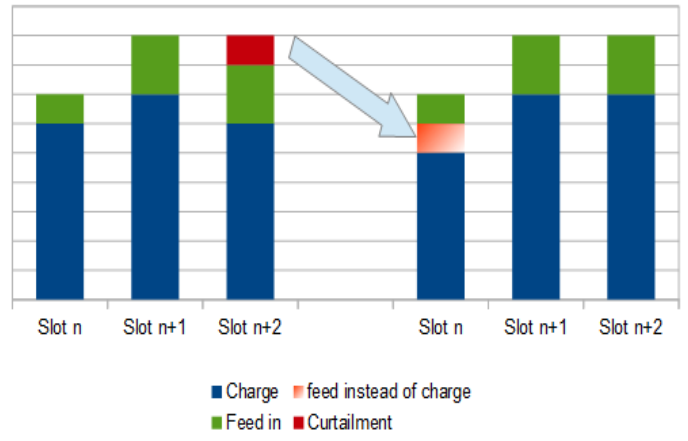
Figure 6. A graphical illustration of one iteration of Algorithm 2 for lines between 23 and